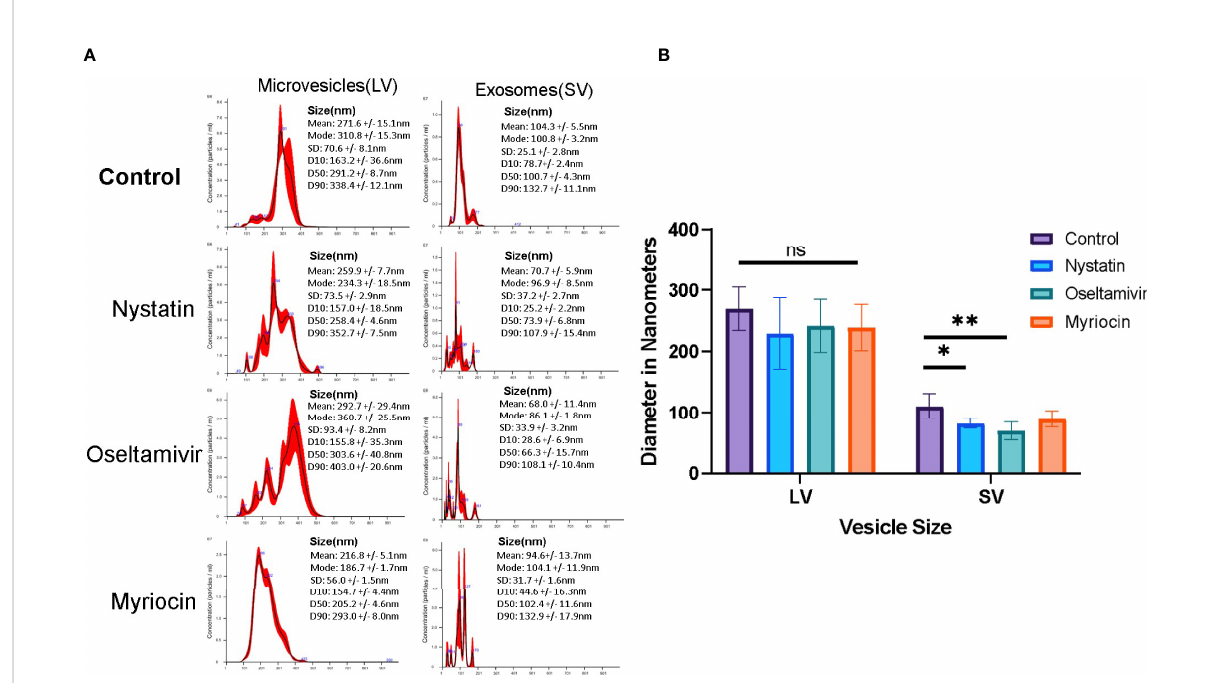
FIGURE 5 Characterization of vesicle population released by Giardia . (A) Large vesicular particles (LVs) and small vesicular particles (SVs) were isolated (Gavinho et al., 2020) and identi fi ed using a NanoSight. Results show a comparison of LVs and SVs from control, nystatin (27 m M), oseltamivir- (20 m M) and myriocin (20 m M) treated Giardia trophozoites. (B) NanoSight statistical comparisons of the sizes between LVs and SVs from data acquired from nanoparticle tracking analysis (NTA). The data is representative of at least three independent experiments and represented as ± SD. *P < 0.05; **p<0.001; ns, non-signi fi